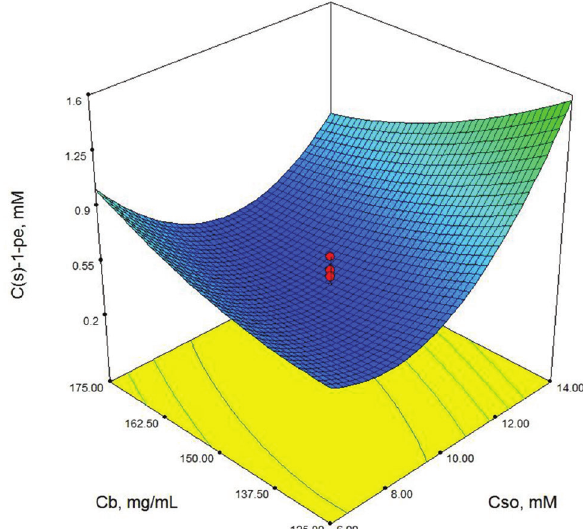
Figure 6: Contour-plot of ( S )-1-phenylethanol concentration: The effect of initial substrate concentration and biocatalyst concentration. Other variable is held at zero level. t = 48 h, C